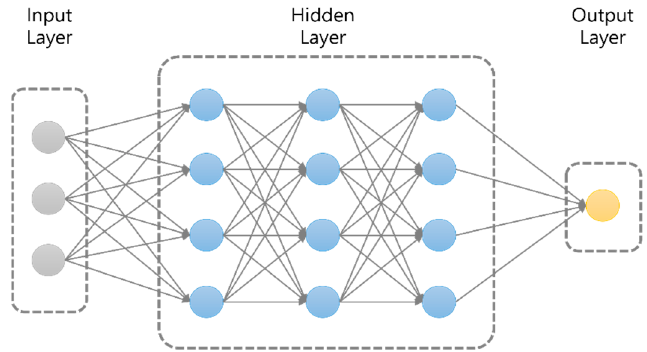
Figure 5. The structure of the DNN model.